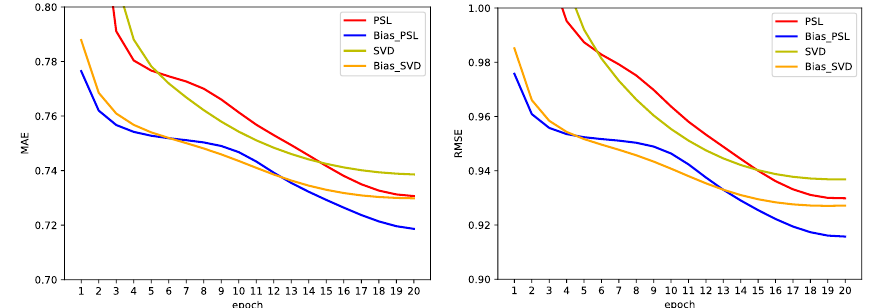
Figure 2. Training process of compared models on MovieLen-100 K with 50 latent factors.